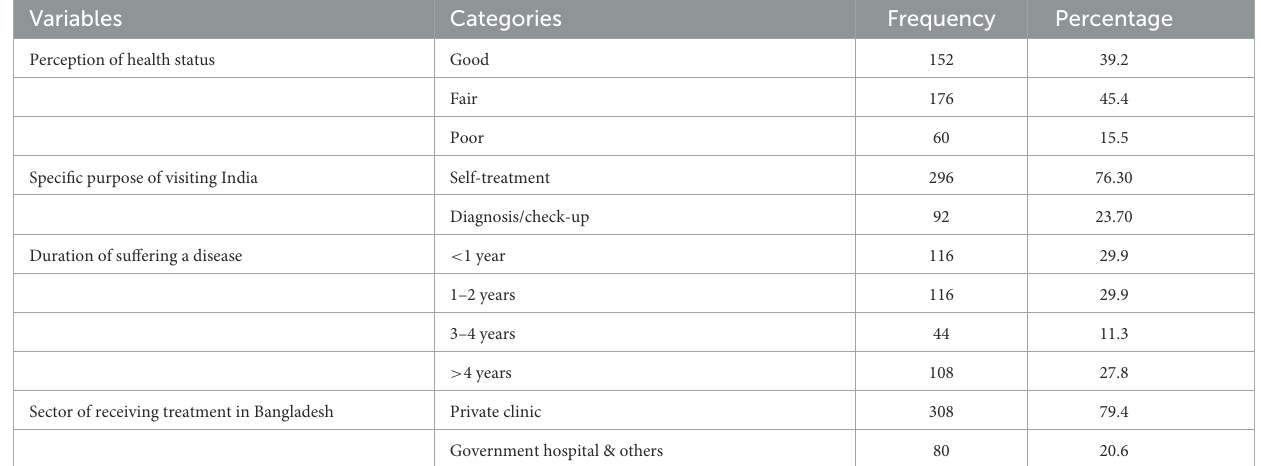
TABLE 2 Health-related characteristics of study